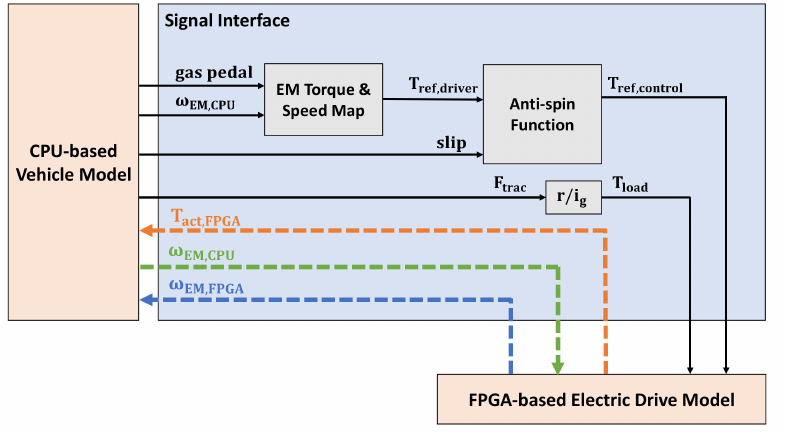
Figure 5. Closed-loop interface between the vehicle model and the electric drive